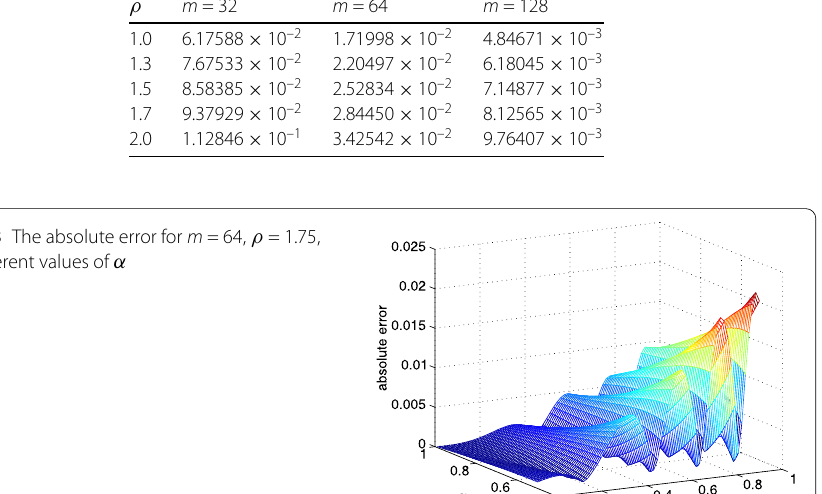
Figure 4 Exact and numerical solutions for m = 64, ρ =